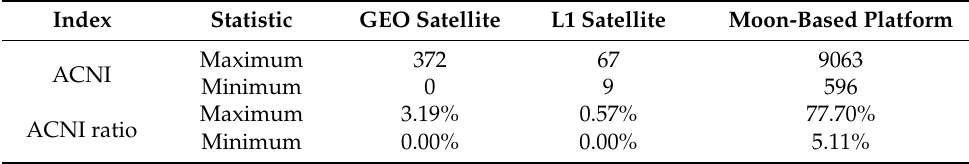
Table 2. A comparison table of the angular characteristics of each observation